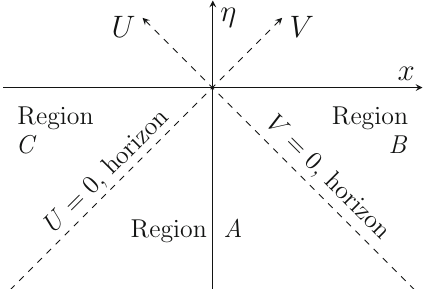
Fig. 4 The expanding FLRW patch in de Sitter space is described by η ≤ 0 and −∞ < x < ∞ , and can be covered by the A , B and C coordinate systems defined in (46), (49) and